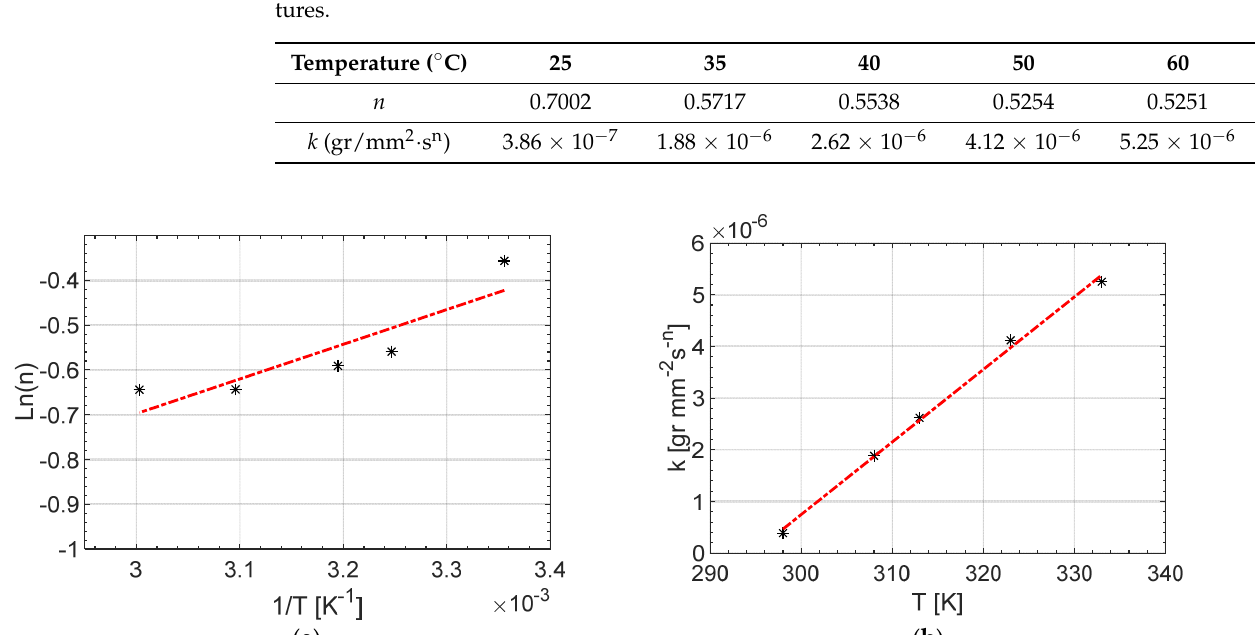
Figure 12. Line fitting on ( a ) n and ( b ) k changes by temperature to obtain predictive models based on Equations (9) and (10).